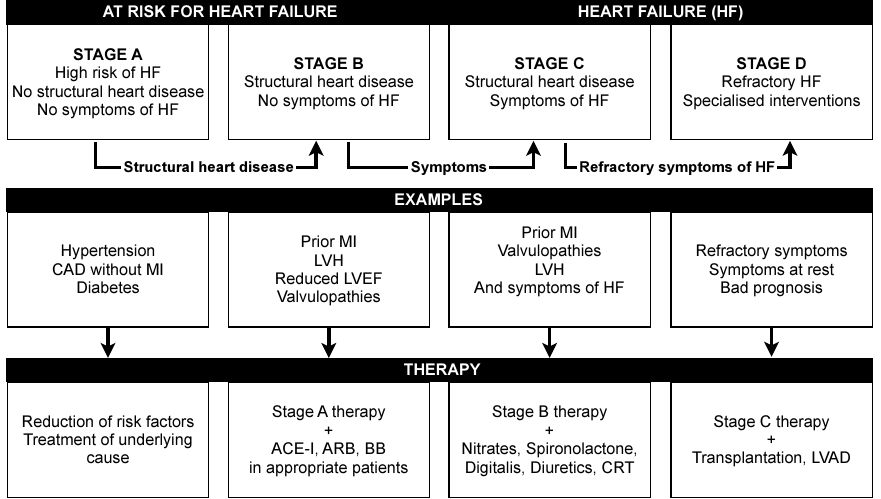
Stages in the devel- opment of heart fail- ure from risk factors of heart failure to end stage disease, under- scoring the progres- sive nature of the dis- ease and the conse- quences in therapy. CAD: Coronary artery disease, MI: Myocar- dial infarction, LVH: Left ventricular hy- pertrophy, LVEF: Left ventricular ejection fraction, ACE-I: An- giotensin converting enzyme inhibitors, BB: Beta blockers, LVAD: Left ventricular assist device (adapted from